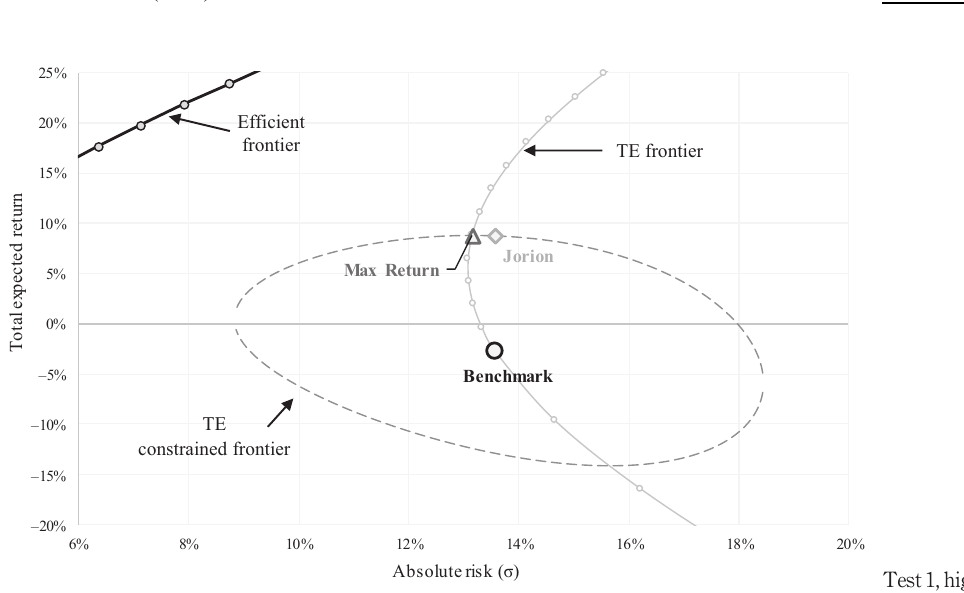
Figure 11. Monthly return difference between JB and MR portfolios, Test 2, high volatility